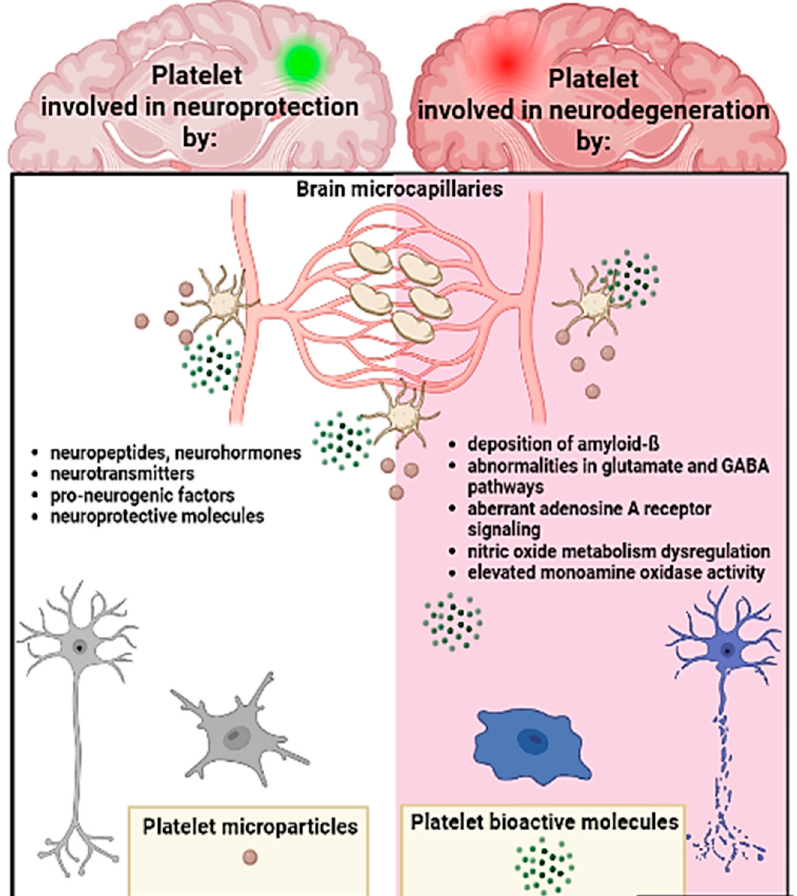
Figure 4. Platelet role in healthy brain function and association with neurodegenerative disorders. The left side of the figure shows, the role of platelets in brain physiological processes, including their modulation of neurogenesis and synaptogenesis through the release of bioactive molecules contained in their granules or platelet-derived exosomes and microparticles, their bridging function between the blood and the brain, and their contribution to neuronal communication through the release of neurotransmitters. In contrast, the right side displays their involvement in neurodegenerative processes such as their putative role in β -amyloid plaque formation in AD or metabolic dysregulation associated with Huntington’s disease. Created in BioRender.com (accessed on 12 January